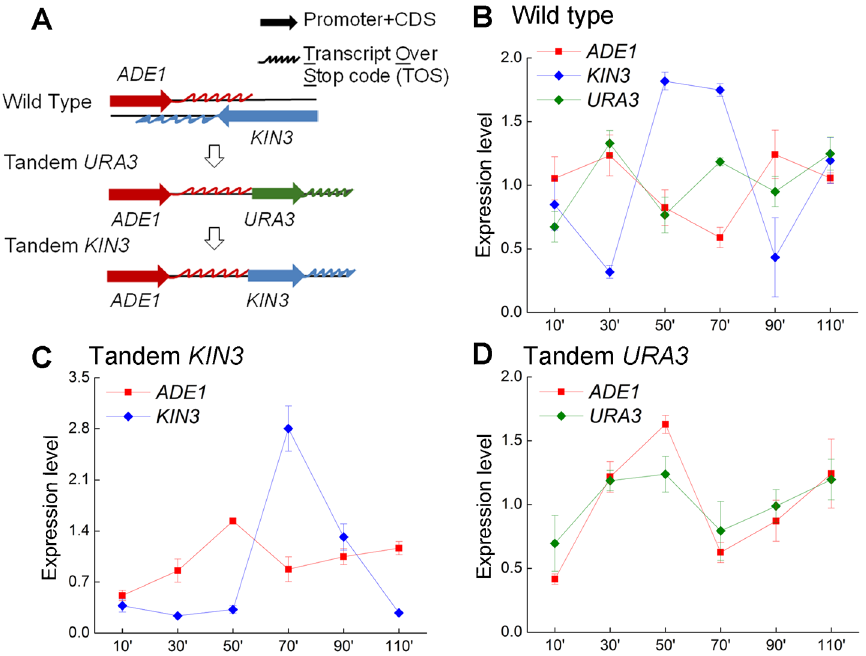
Figure 5. Cell-cycle expression of the gene pair ADE1 and KIN3 , in convergent and tandem orientation. ( A ) Three strains tested: (I) wild type, in which ADE1 and KIN3 were in convergent orientation; (II) tandem URA3 , in which KIN3 was replaced with URA3 , and ADE1 and URA3 were in tandem orientation; and (III) tandem KIN3 , in which ADE1 and KIN3 were in tandem orientation. ( B ) Cell cycle expression of the three genes ADE1 , KIN3 and URA3 in the wild type strain. ( C ) Cell cycle expression pattern of the genes ADE1 and KIN3 in tandem orientation. ( D ) Expression of the genes ADE1 and URA3 in the tandem URA3 strain.